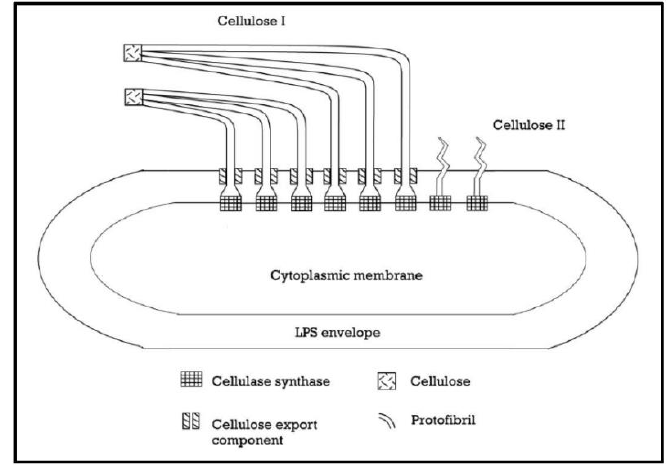
Figure 1. Production of cellulose microfibrils by Acetobacter xylinum